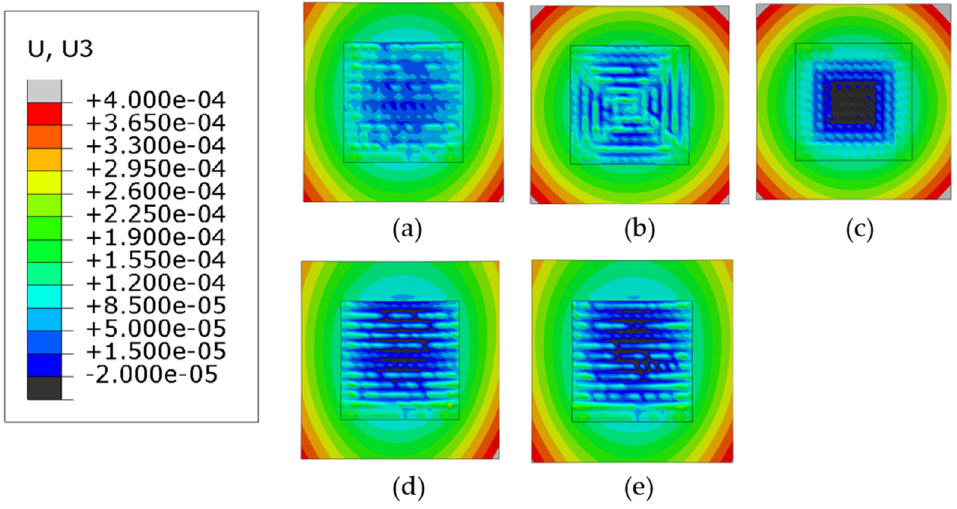
Figure 13. Deformation distribution of different deposition patterns at the end of the simulation, when phase transformations are not considered, (top view, unit: m); ( a ) alternate, ( b ) in–out, ( c ) out–in, ( d ) raster, ( e ) zigzag.